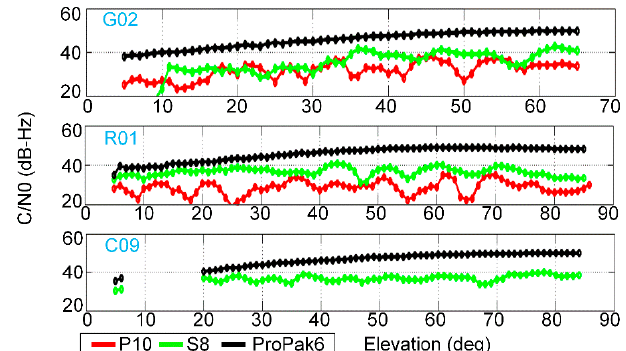
Figure 6. Average C/N0 values vs. elevation for GPS, GLONASS, and BDS observations from S8, P10, and geodetic devices. The C/N0 values within an elevation range of 1° are classified into one group, and compute a group average.